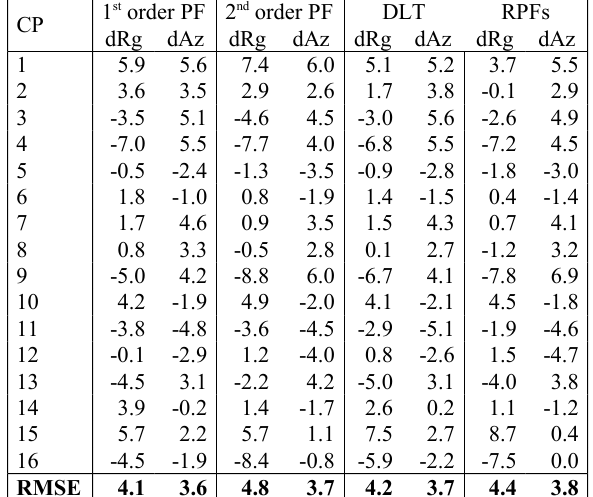
Table 2. Test C: Residuals and RMSE (pixels) of